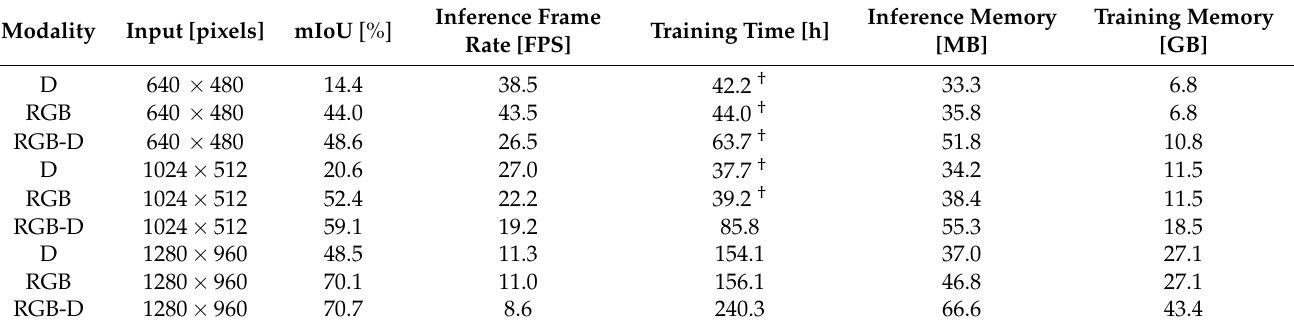
Table 1. Performance of multi-class plant species semantic segmentation based on distance (D), color (RGB) and combination of color and distance (RGB-D) for three input image resolutions using ESANet. Model performance parameter is the mean Intersection over Union (mIoU) given in percent. Other model parameters, i.e., inference frame rate in frames per second (FPS), training time in hours, memory consumption during training and inference in GB, were evaluated on an NVIDIA GeForce Quadro RTX 8000. † Models were trained on NVIDIA GeForce RTX